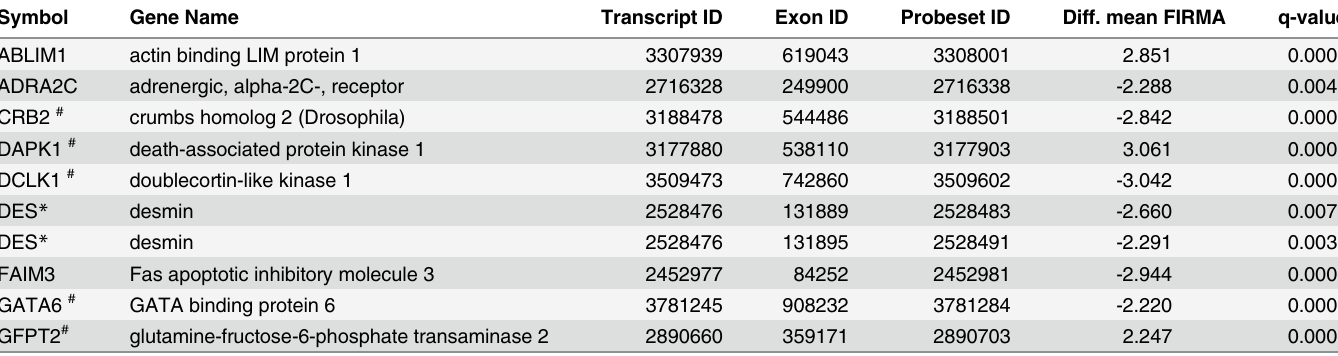
Table 9. A list of the alternative splicing events associated with the regional differences of the adipose tissue of pregnant women.